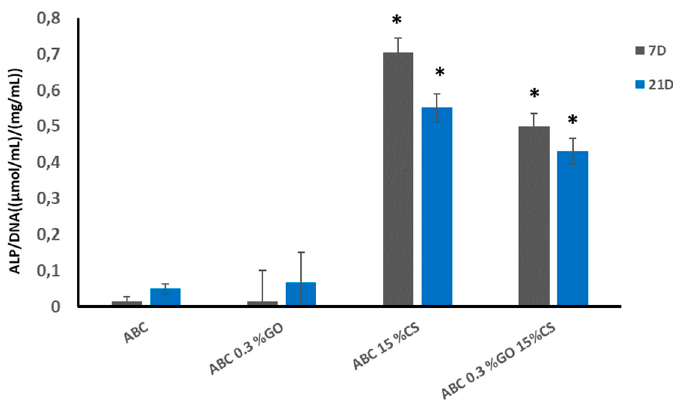
Figure 10. Variation of ALP activity expressed as the variation of p-nitrophenol concentration liberated in HOb cell cultures normalized by DNA content in the culture. Statistical analysis ( n = 8) against control ABC group was performed at the significance level of p < 0.01.